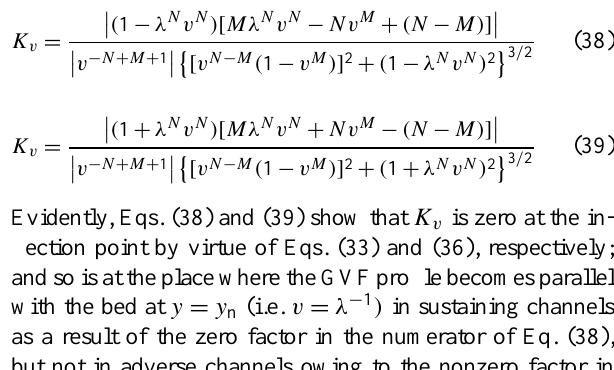
value as a parameter for GVF profiles in sustaining channels and